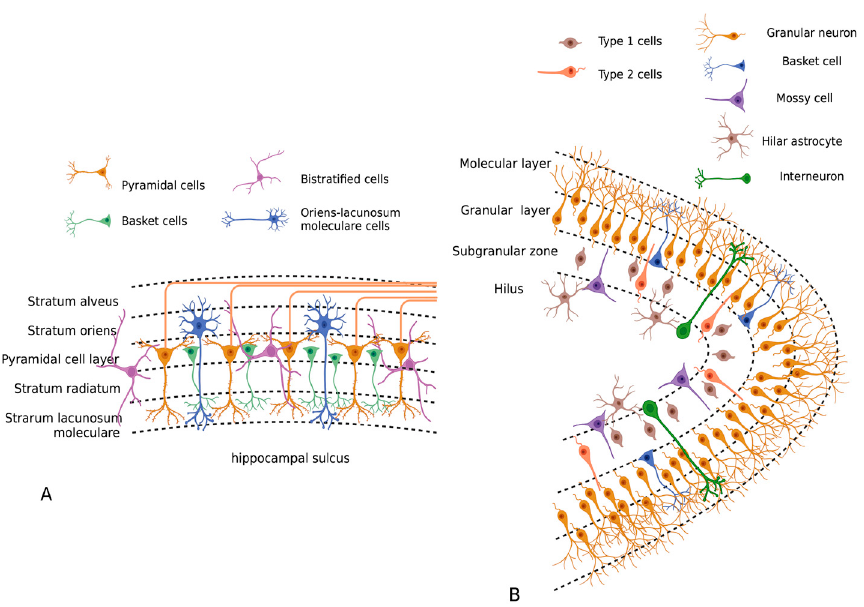
Figure 1. Structure of hippocampus ( A ) and gyrus dentatus ( B ). Created in BioRender.com. The hippocampus also has C-shape and is divided into three different areas based upon histology features: CA1, CA2 and CA3. All of them have five cell layers (Figure 1A). The stratum alveus contains the alvear pathway and is represented by the oriens-lacuno- sum moleculare cells and basal dendrites of pyramidal cells. The pyramidal cell layer con- tains pyramidal cells and a number of basket cells, and the stratum radiatum with stratum lacunosum-moleculare contains a perforant pathway composed of the apical dendrites of pyramidal cells and hippocampal afferent fibers coming from the entorhinal cortex. During adult neurogenesis, the neuronal stem cells became fully maturated neurons.